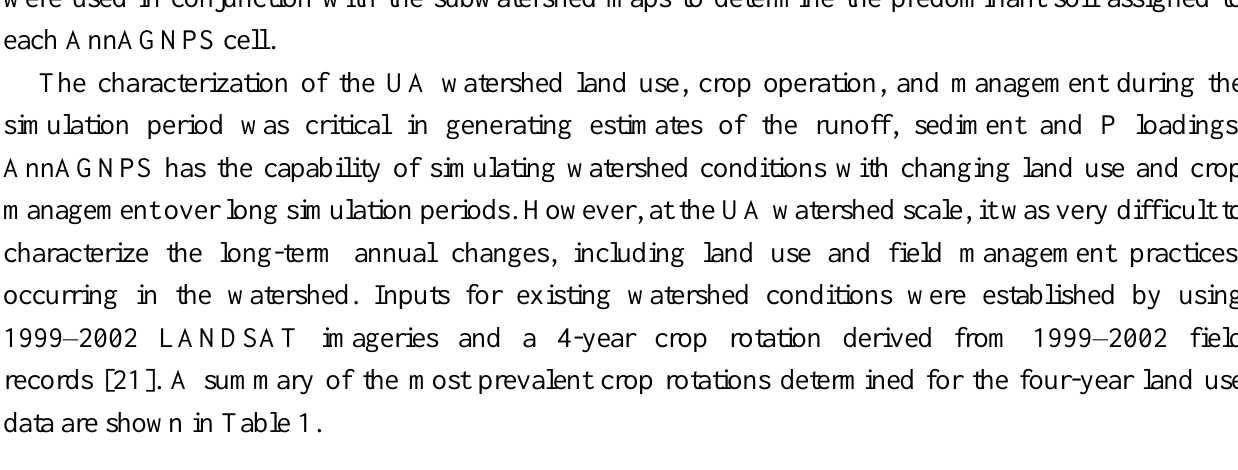
Table 1. Crop rotations summarized for the 4-year land use, C (Corn), S (Soybeans), W (Wheat) and F (Fallow meaning permanent